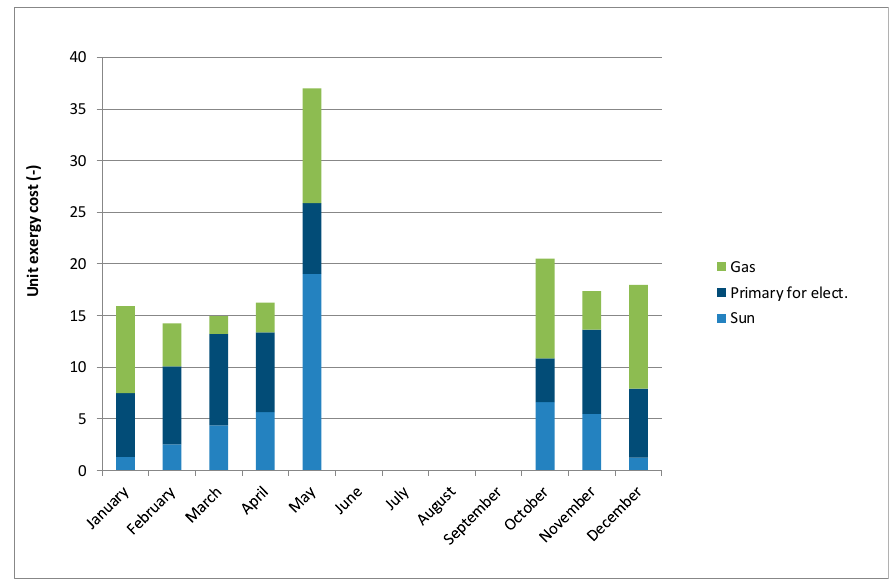
Figure 23. Gas boiler: Cost formation by irreversibility.